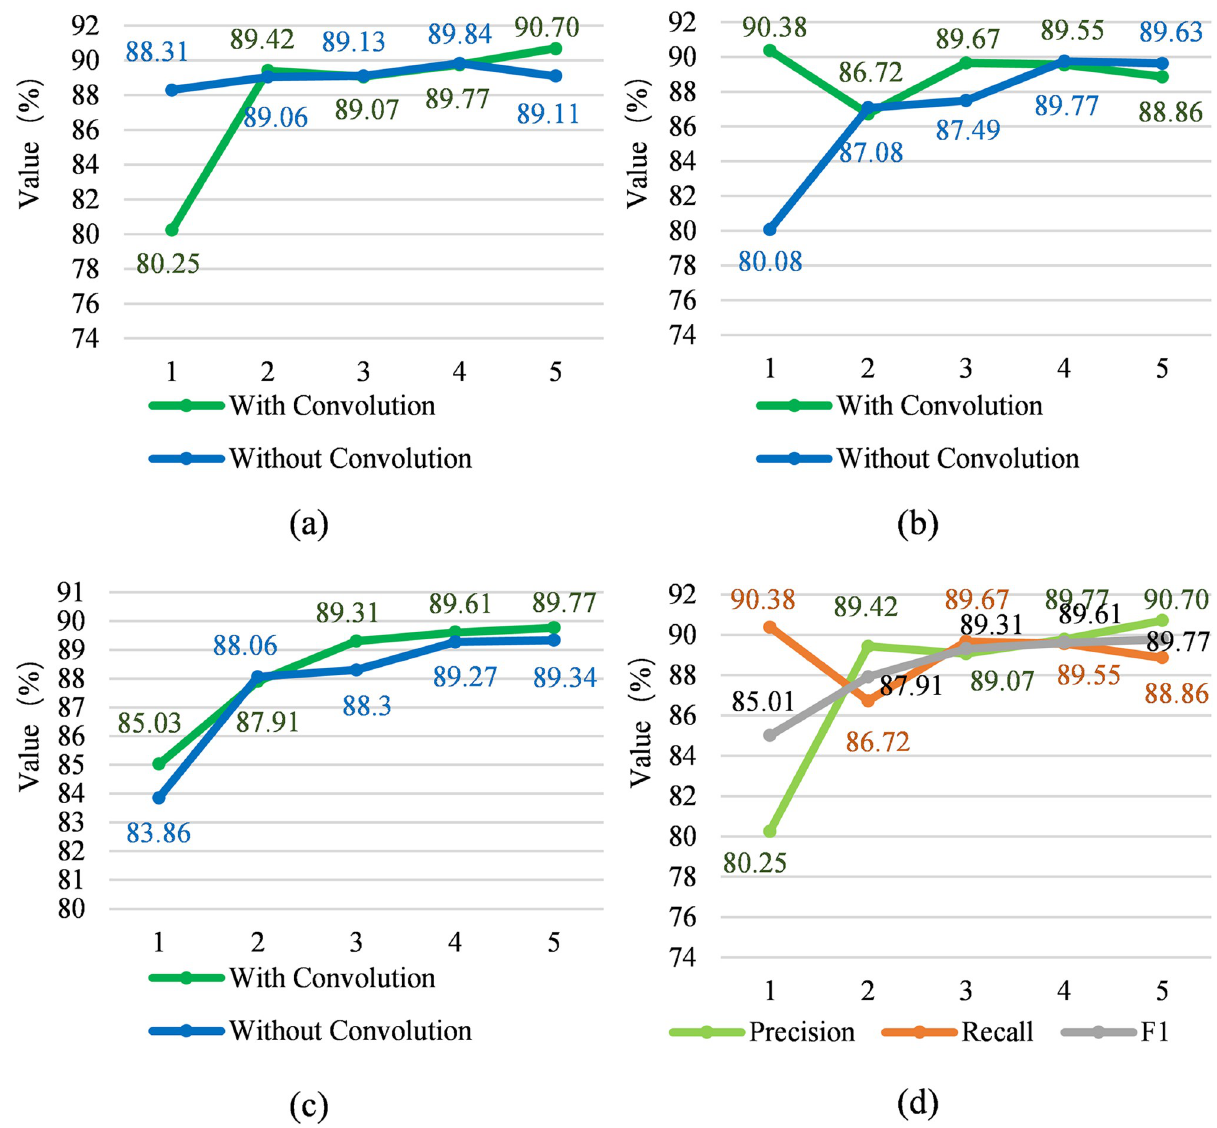
Fig 3. Precision, recall and F1 rate of piecewise convolution and pooling